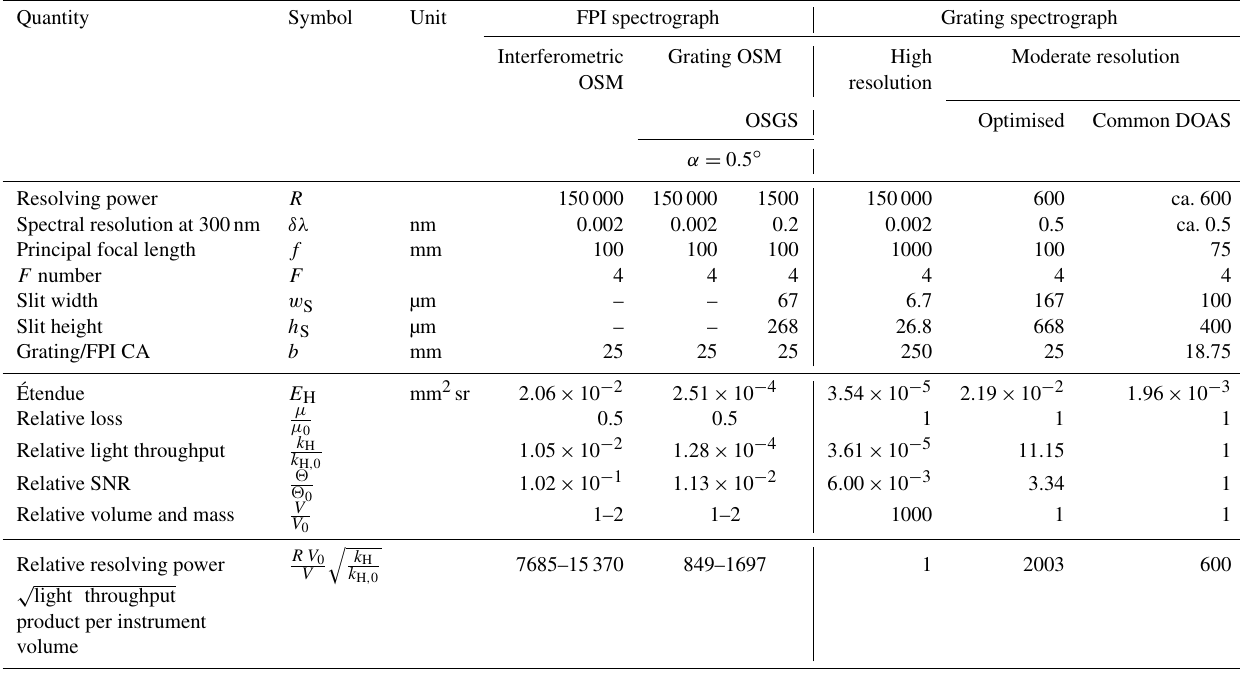
Table 1. Comparison of an FPI spectrograph and a GS. All spectrographs have an F number of 4 and, to ensure mobility, a focal length of 100mm, except for the high-resolution GS (see Sect. 3.2.1 for details). The light throughput and SNR are calculated relative to that of a moderate-resolution GS, commonly used for DOAS measurements and, thus, with a known